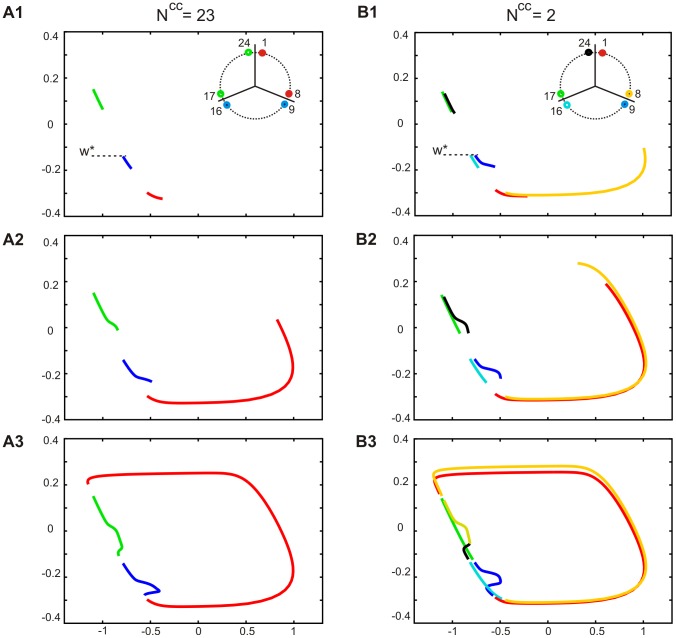
Effect of network connectivity on the trajectory of cells expressing 3-phase pattern.Shown are consecutive steps of phase plane evolution of cells expressing 3-phase activity pattern in fully connected (A) and Ncc2 network (B). A. Cells belonging to different groups (solid color curves) evolve in the silent phase (A1) and during the active phase of a leading group (A2–3). Within each group trajectories are identical. B. Shown is the evolution of cells placed at the borders between groups (insert, B1) starting from the same W* (horizontal line) and during the same time intervals as in A. Cells connected with a less advanced group (like cell 8 from the leading group connected with cell 9, insert) are leaders in their own group during the active phase (cf. yellow and red curve, B1–2). Notice no clear difference in the size of critical (bottom) deflection in A3 and B3. Parameters: gel = 0.18. Phase plane coordinates: V (abscissa), W (ordinate).